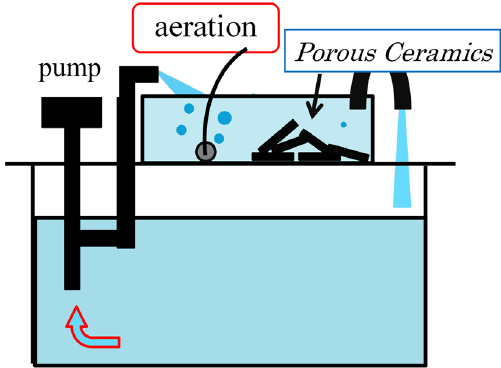
Fig. 1 Experimental setup for water purification using the porous ceramics under